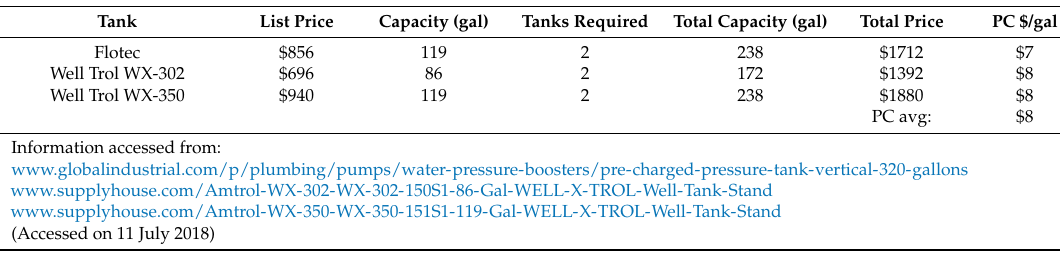
Table A10. Price per capacity scaling factor calculations for pre-charged tanks.